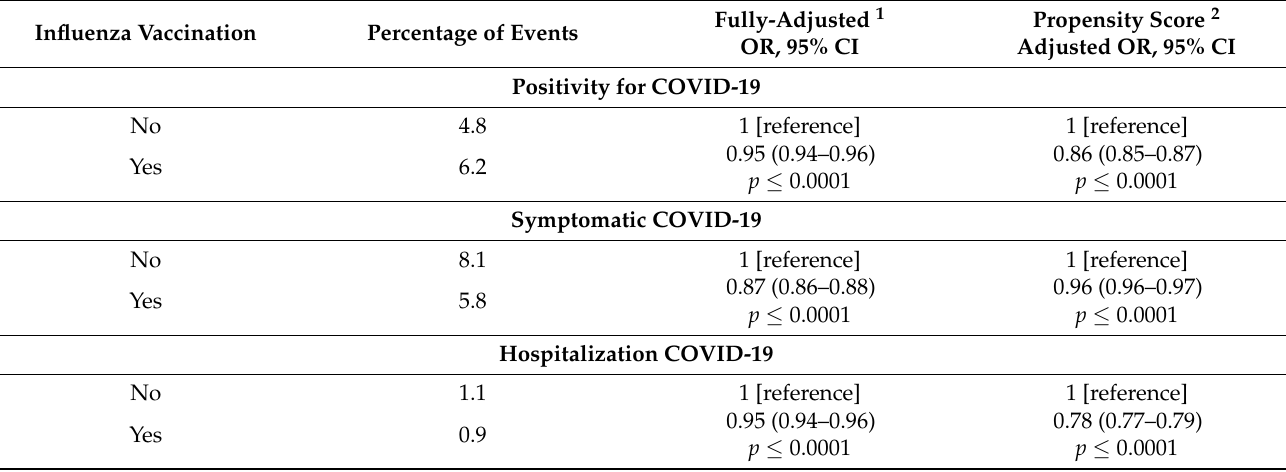
Table 2. Association between influenza vaccination and COVID-19